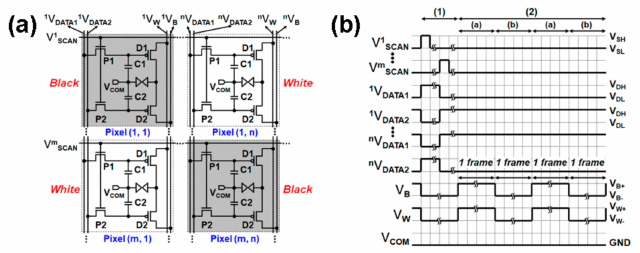
Figure 3. ( a ) Circuit diagram showing arrangement of multiple pixels and ( b ) timing chart of driving signals.